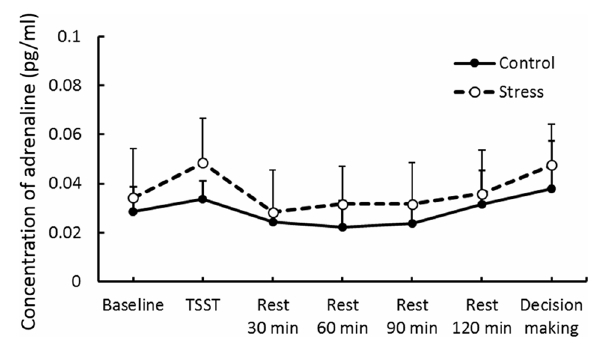
FIGURE 5 | Adrenaline concentration in each group. Error bars indicate standard errors of means.